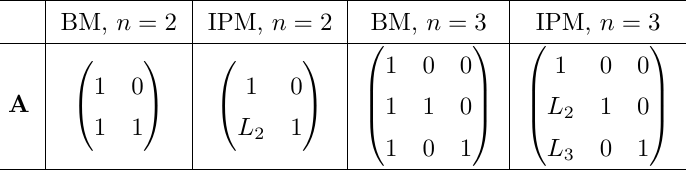
Table 3: Various choices of generator matrix A over F n × n